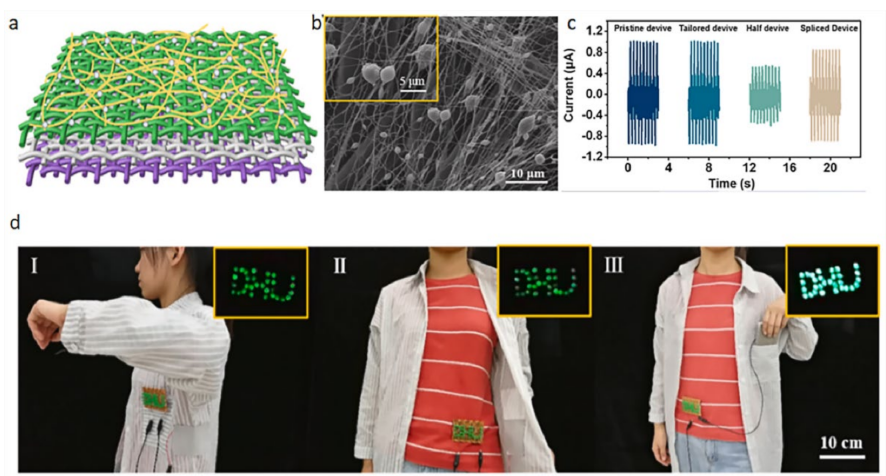
Figure 13. Model diagram and performance diagram of power generation fabric. ( a ) Model diagram, ( b ) SEM images, ( c ) voltage output under different conditions, ( d ) with different body movements, and the LED lights will glow